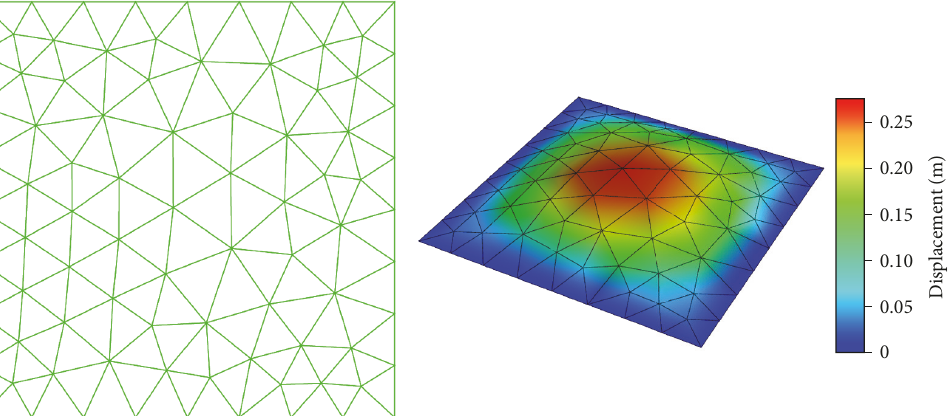
Figure 3: Hard simply supported square plate 3.0 m × 3.0 m × 0.1m made of polyurethane foam: the initial mesh and the isometric view of the resulting vertical deflection of the plate.